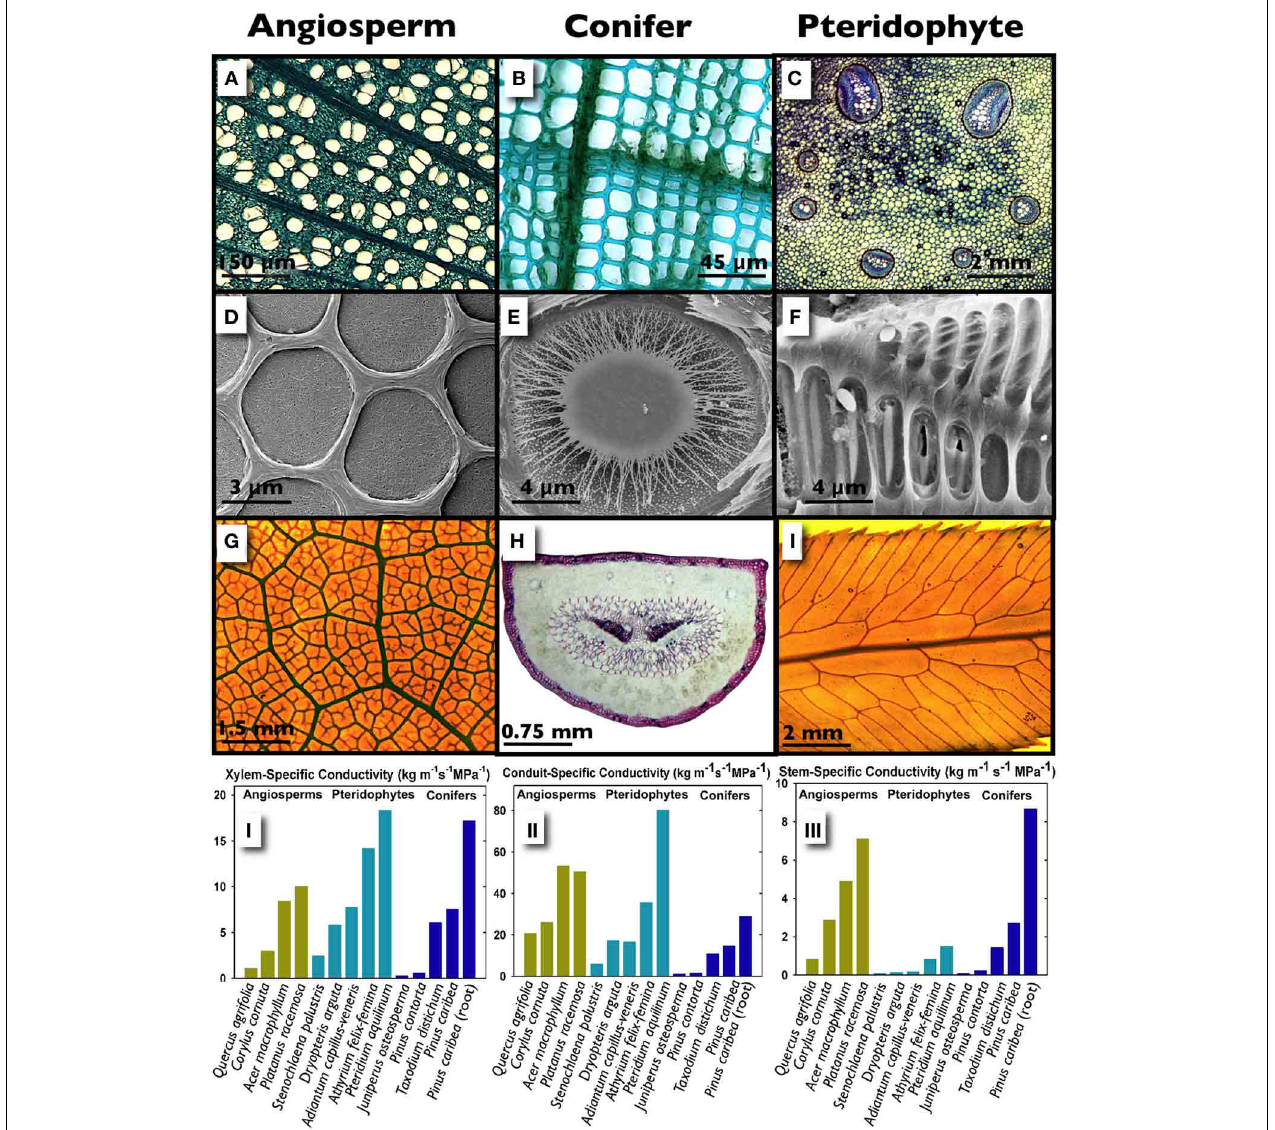
FIGURE 1 | A structural and hydraulic comparison of angiosperm and conifer stems, and a Pteridophyte stipe. Transverse sections of diffuse-porous wood in stems of Platanus racemosa showing vessels embedded in a dense matrix of fibers ( A ; image courtesy of Prentice), the tracheid-based xylem of Pinus contorta (B) and the primary vascular tissue arranged in seven bundles in the stipe of Polypodium aureum ; within the bundles, clear xylem conduits are surrounded by blue-staining phloem ( C , image courtesy of Rico). The homogoneous pit membranes of Cladrastris sinensis ( D , image courtesy of Jansen), the torus-margo pit